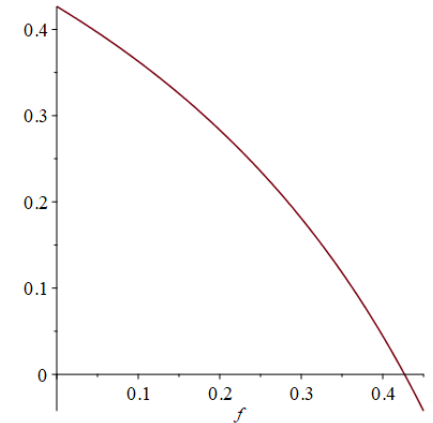
Figure 1. The impact of default probability and revenue distribution on the project utility